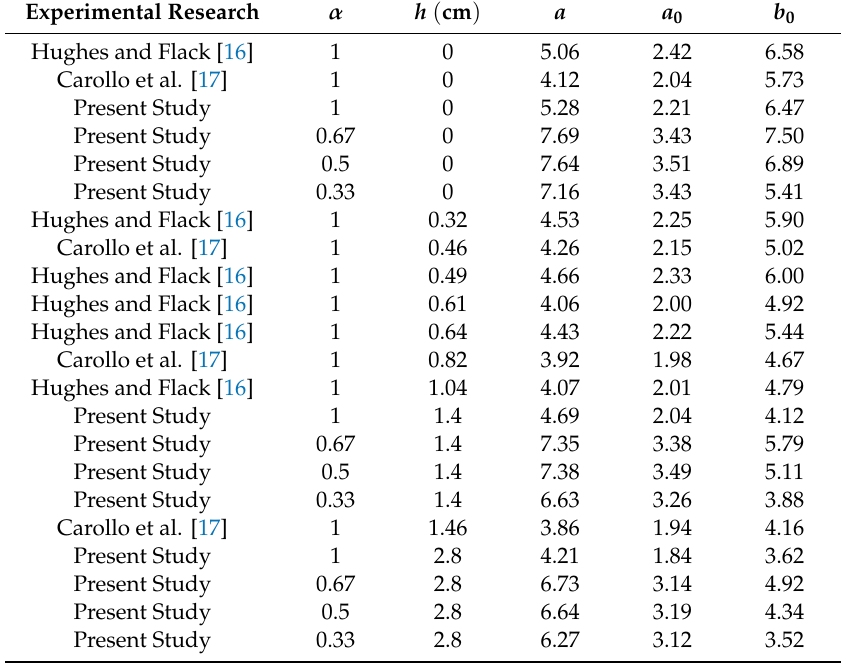
Table 4. Values of a , a 0 , and b 0 coe ffi cients obtained from the experimental data of this research and determined by the previous investigations. Reprinted with permission from